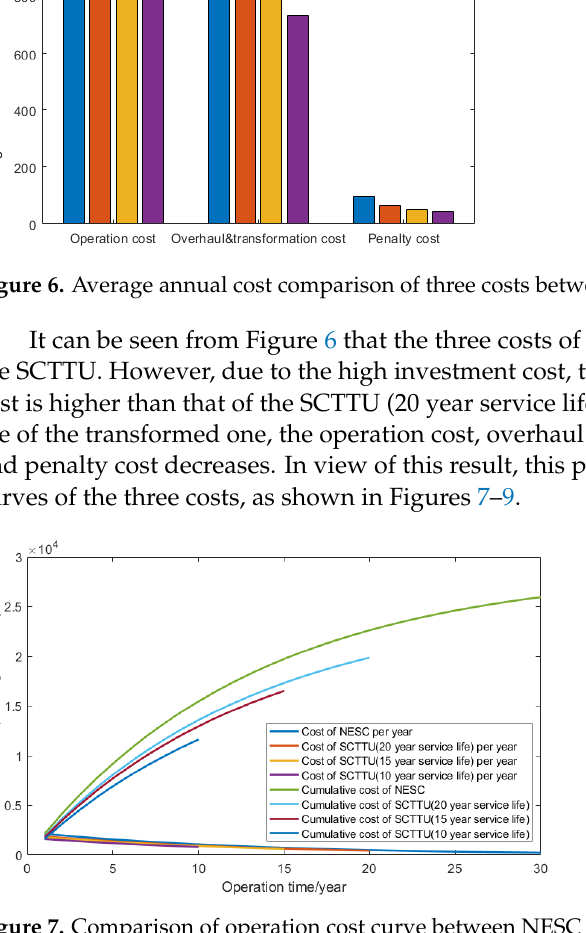
Figure 7. Comparison of operation cost curve between NESC and SCTTU.